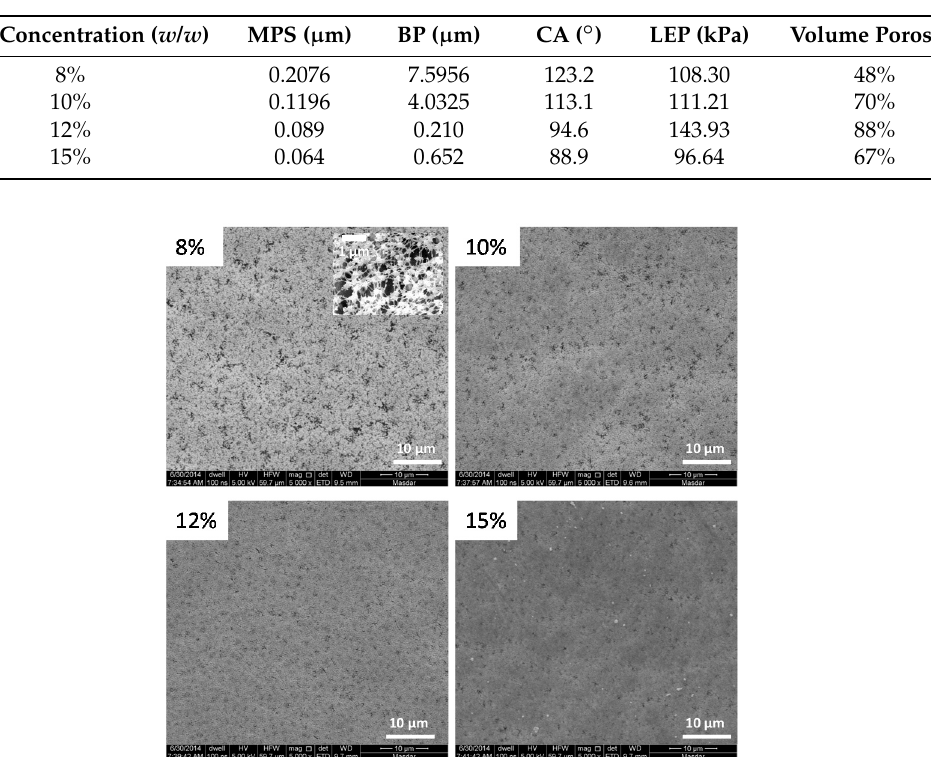
Table 3. Properties of membranes cast using PVDF solutions of different concentrations at cast thickness: 500 µ m, relative humidity (RH): 60% and exposure time: 30 min.